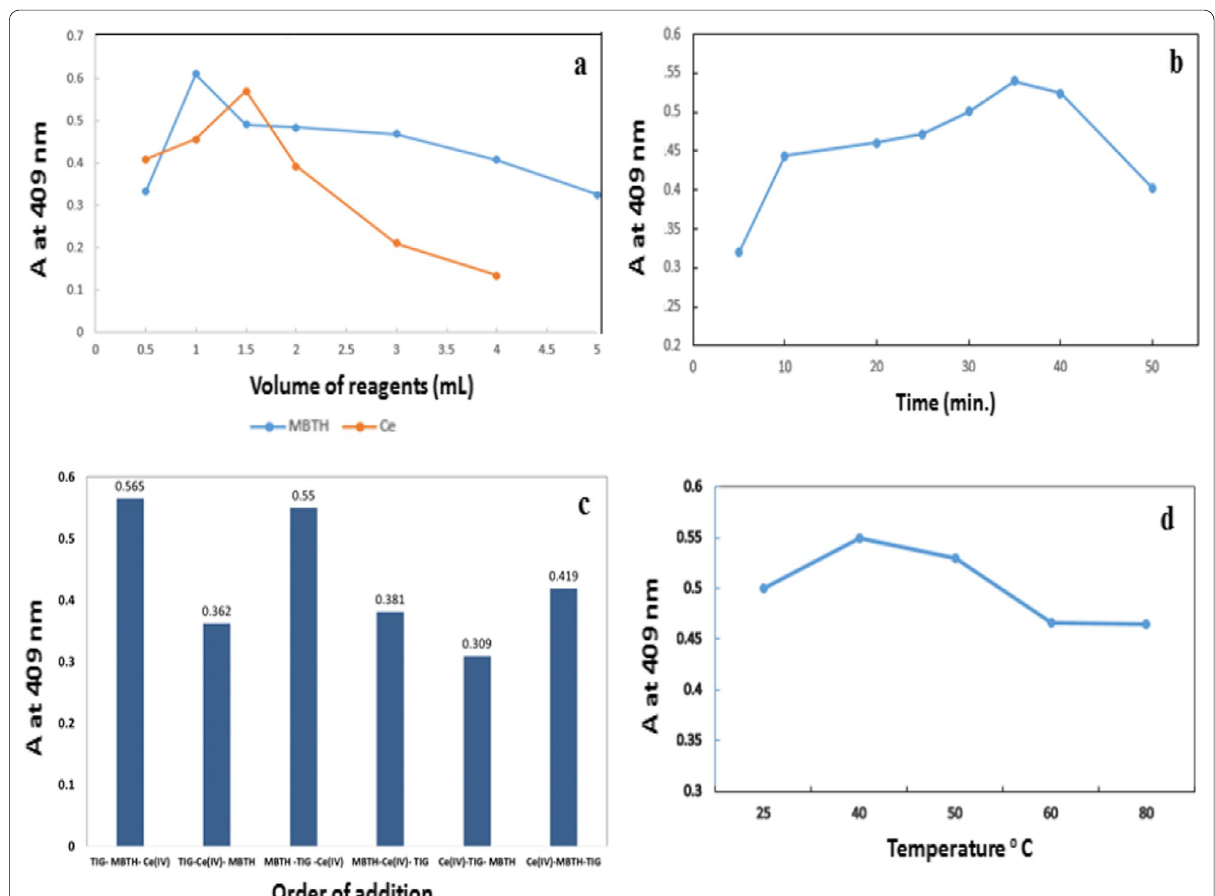
Fig. 6 ( a ) Studying the effect of volume of the reagents, ( b ) the effect of reaction time, ( c ) the effect of order of addition, ( d ) temperature on the